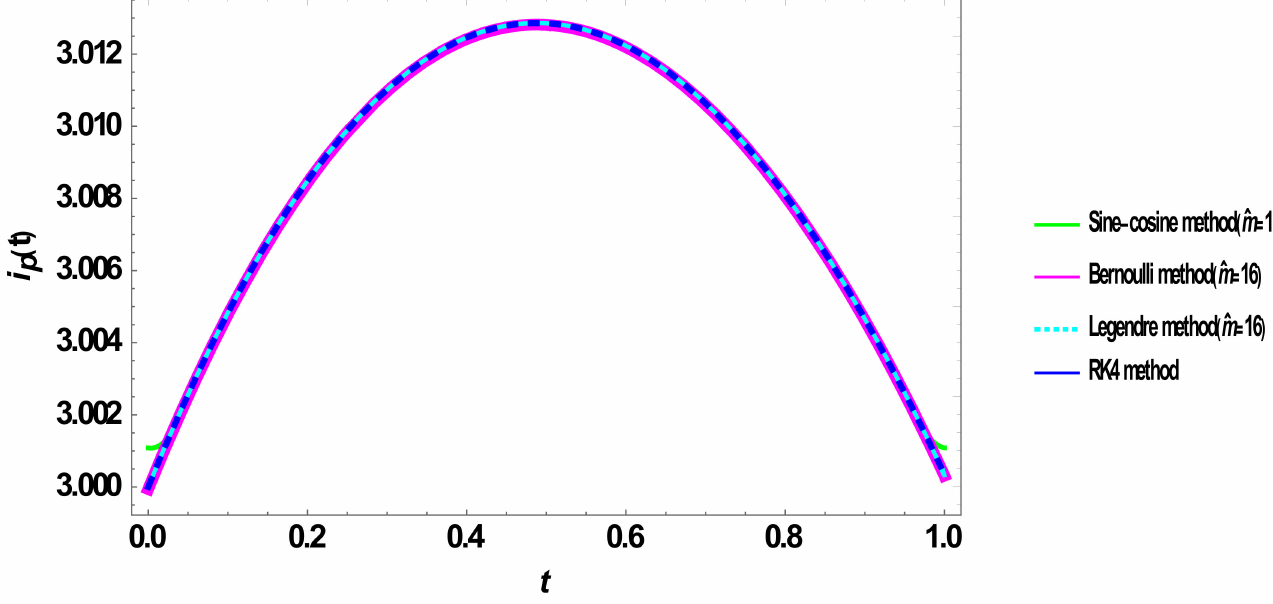
Figure 3. Comparison of the numerical solutions of i p ( t ) by using the sine–cosine wavelets method, Bernoulli wavelets method, ALPs and RK4 methods for υ =